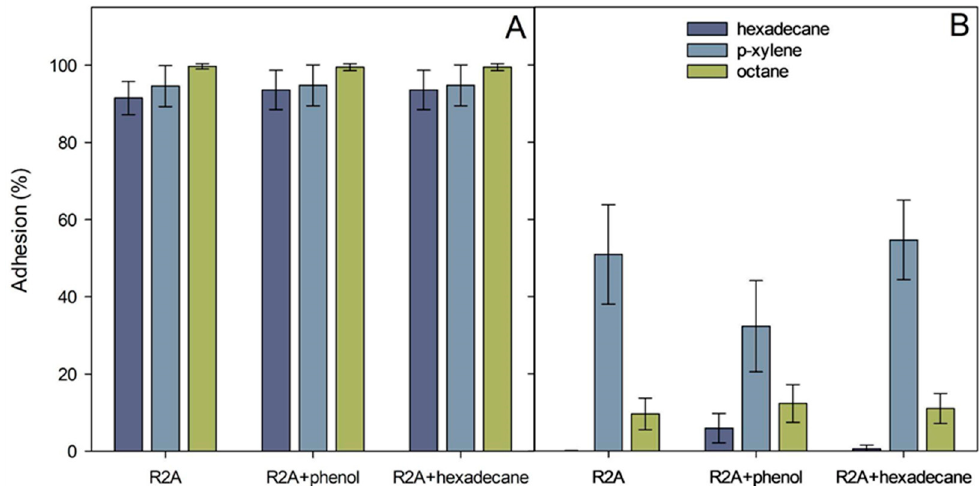
Figure 8. Adhesion (%) of A. venetianus ICP1 ( A ) and P. oleovorans ICTN13 ( B ) cells to hexadecane, octane, and p-xylene. Cells were grown overnight on R2A medium, R2A supplemented with 1.3 mM phenol or 0.1% hexadecane. The average values (three biological experiments with at least with three technical parallels) obtained from the MATH test are presented with standard deviations.